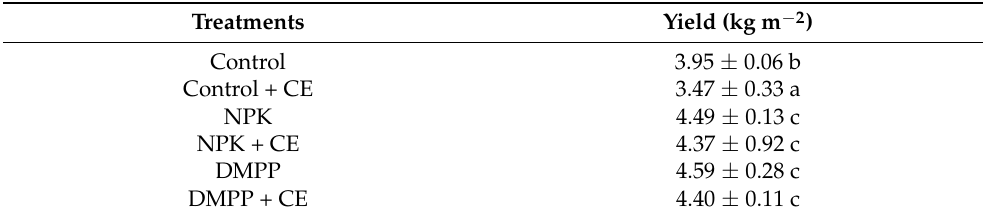
Table 2. Influence of different fertilizer treatments on spinach yield. Different letters indicate significant differences at p < 0.05.